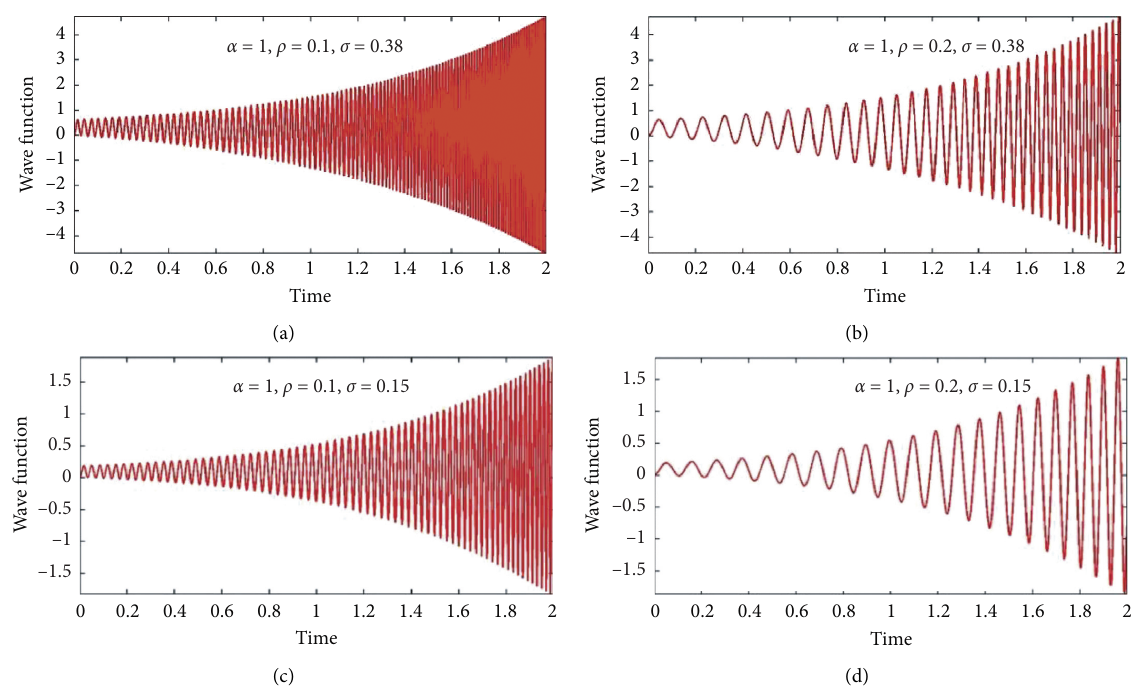
Figure 5: Wave function generated from the partial differential equation at very high kinetic energy. (a) α � 1 , ρ � 0 . 1 , σ � 0 . 38; (b) α � 1 , ρ � 0 . 2 , σ � 0 . 38; (c) α � 1 , ρ � 0 . 1 , σ � 0 . 15; (d) α � 1 , ρ � 0 . 2 , σ � 0 . 15.